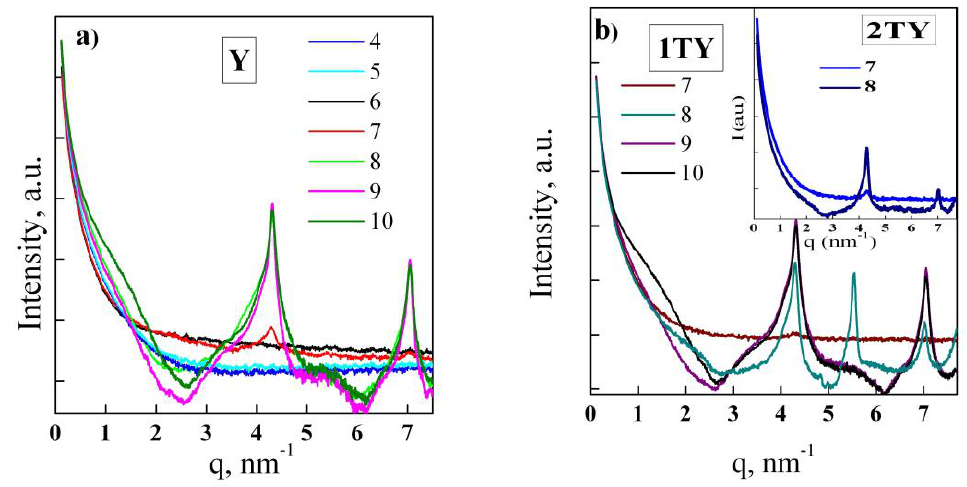
Figure 2. Scattering curves of the samples at different aging times. ( a ) Zeolite Y; ( b ) Ti-containing zeolite Y (1TY means zeolite containing 1% TiO 2 and 2TY means zeolite containing 2% TiO 2 ).